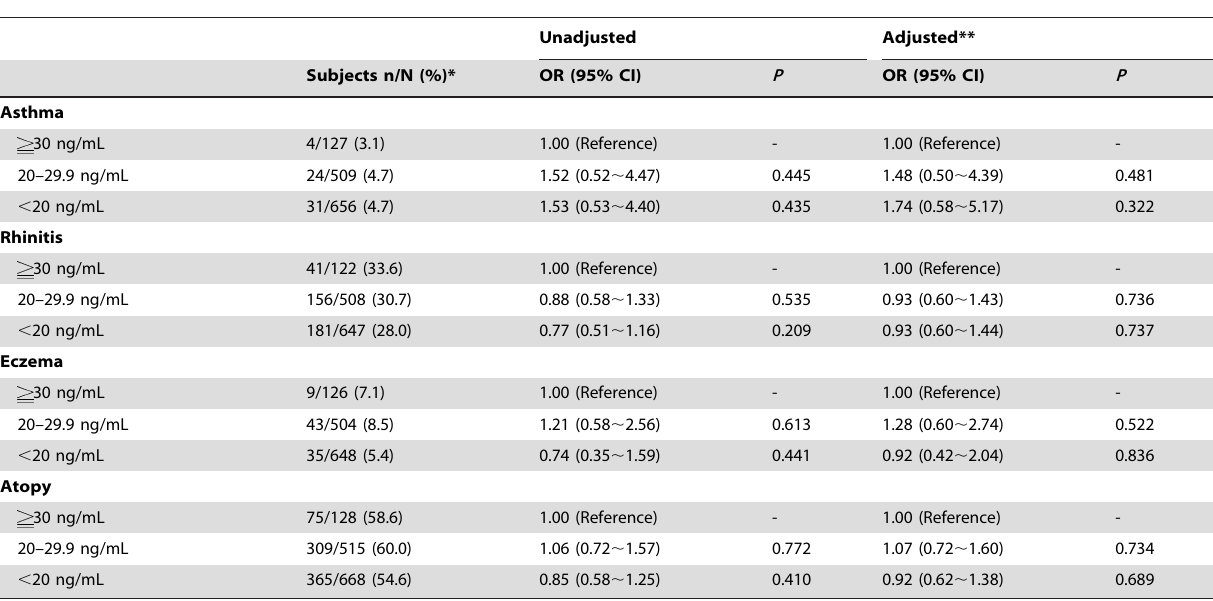
Table 4. Association of serum 25(OH)D status with allergic diseases and atopy.